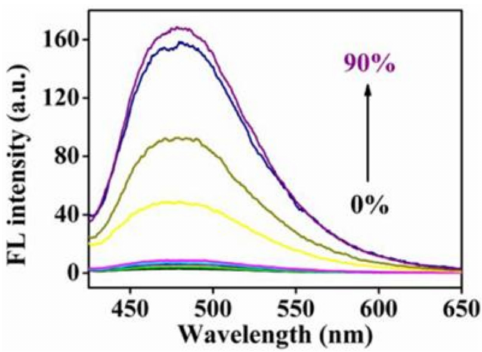
Figure 2. FL spectra of PTD in water-THF mixture with different water fractions, indicating that PTD has typical AIE